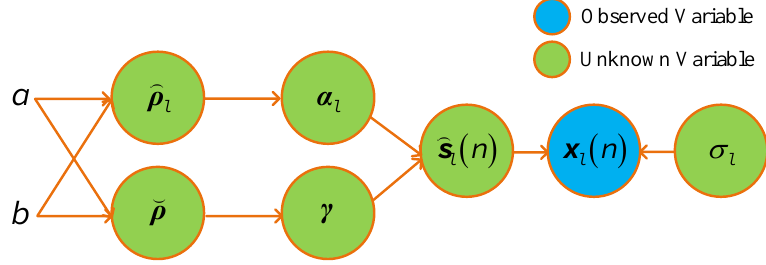
Figure 2. Directed acyclic graph of the hierarchical Bayesian model.